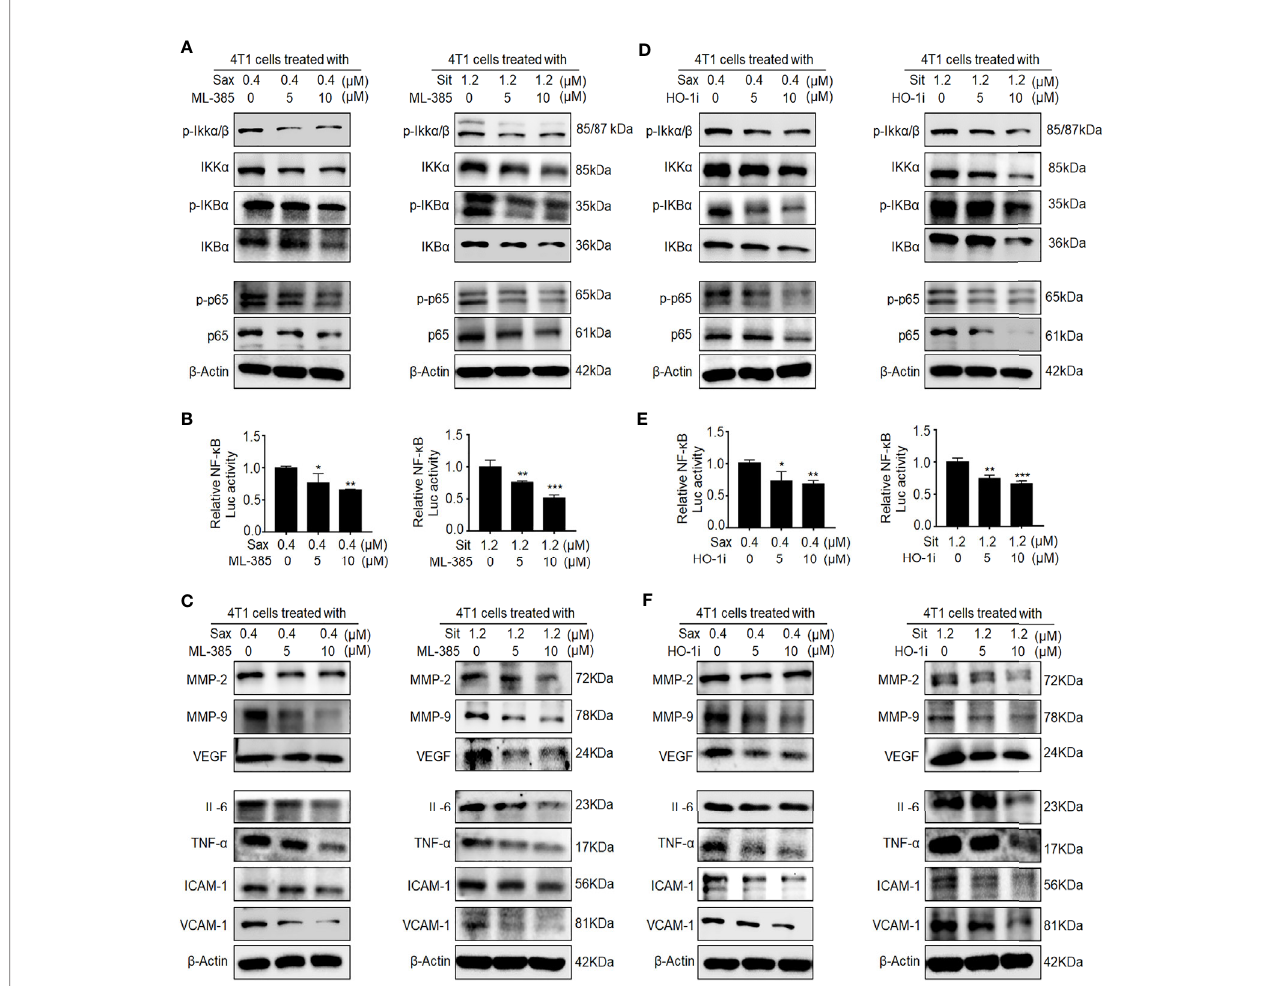
FIGURE 4 | Inhibition of NRF2-HO-1 activation abrogates DPP-4i-driven NF- к B activation. (A – C) NRF2 blockage abrogates DPP-4i-induced NF- к B activation. 4T1 cells were co-treated with Sax (0.4 m M) or Sit (1.2 m M) and NRF2 inhibitor ML-385 (0, 5, and 10 m M), respectively. (A) The expression of p-65, p-p65, and NF- к B regulatory proteins was detected by Western blotting. (B) NF- к B transcriptional activation was analyzed by luciferase reporter assay, and (C) NF- к B-responsive targets were detected by Western blotting. (D – F) HO-1 inhibition attenuates DPP-4i-induced NF- к B activation. 4T1 cells were co-treated with Sax (0.4 m M) or Sit (1.2 m M) and HO-1 inhibitor (0, 5, and 10 m M), respectively. (D) The expression of p-65, p-p65, and NF- к B regulatory proteins was detected by Western blotting. (E) NF- к B transcriptional activation was analyzed by luciferase reporter gene assay. (F) NF- к B-responsive targets were detected by Western blotting. b -Actin was a loading control. Data are presented as mean ± SD of three independent experiments. Representative images are shown. *p < 0.05, **p < 0.01, and ***p < 0.001 between the indicated groups determined by the one-way analysis of variance